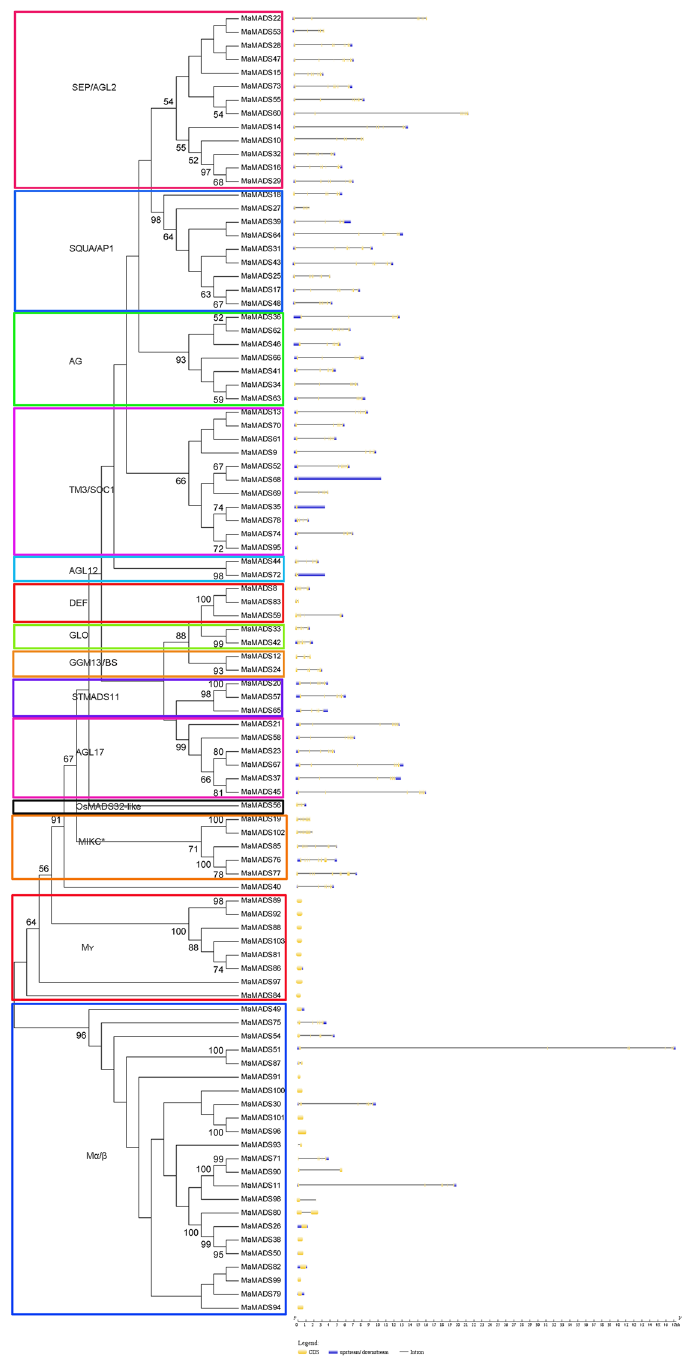
Figure 3. Gene structure analyses of MaMADSes . Exon-intron structure analyses were performed by GSDS database. The blue boxes indicate upstream/downstream, the yellow boxes indicate exons, and the black lines indicate